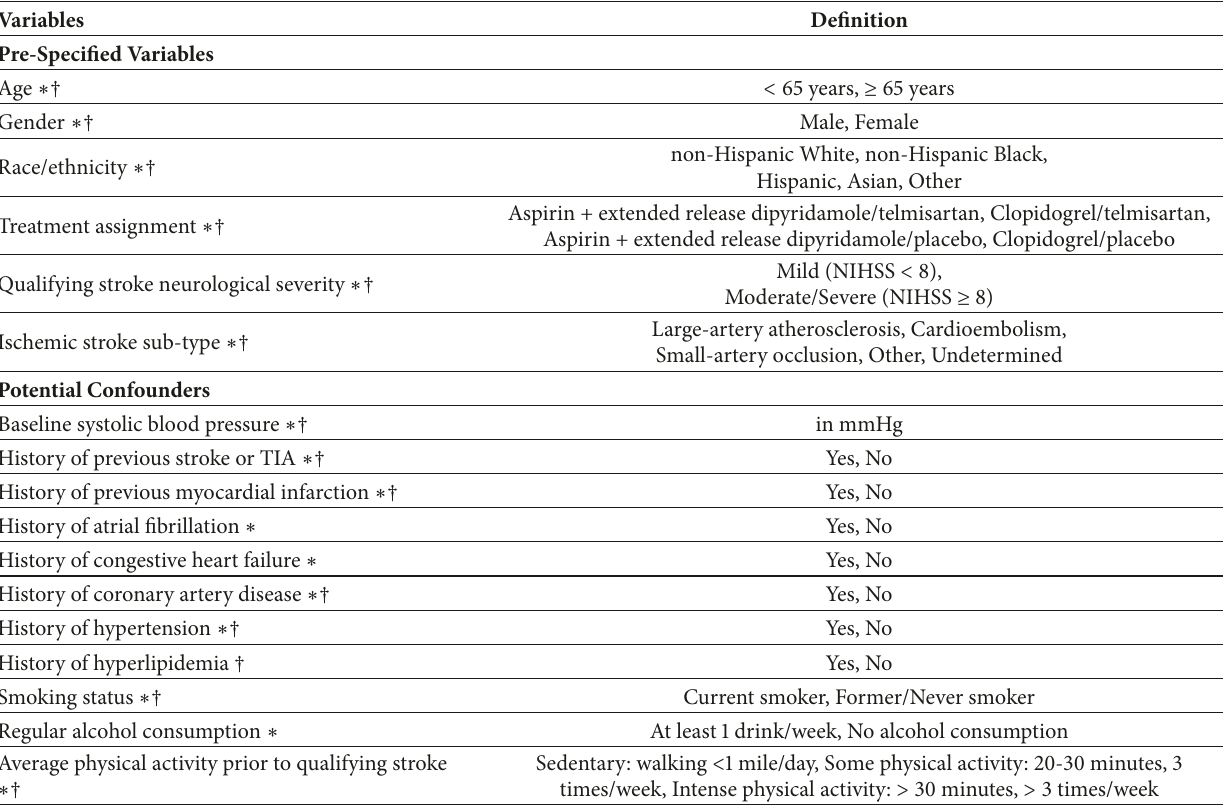
Table 1: Variables and definitions of prespecified variables and potential confounders for